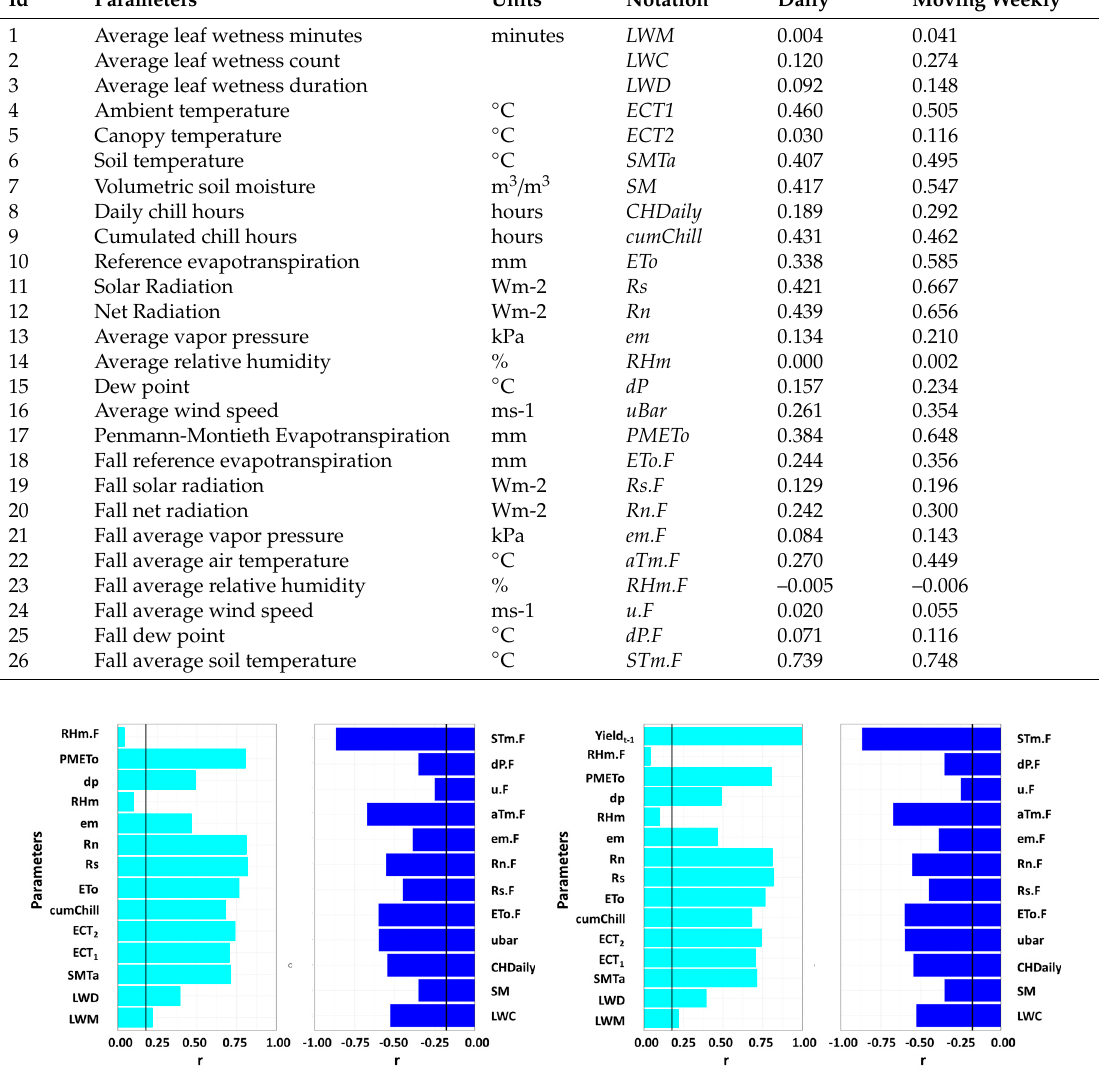
Figure 5. Bar graphs showing the correlations between strawberry yield and other variables as listed in Table 3. The bars below the black line imply that the parameters are insignificant to crop yield. ( Left ) Daily scale. ( Right ) Weekly scale.